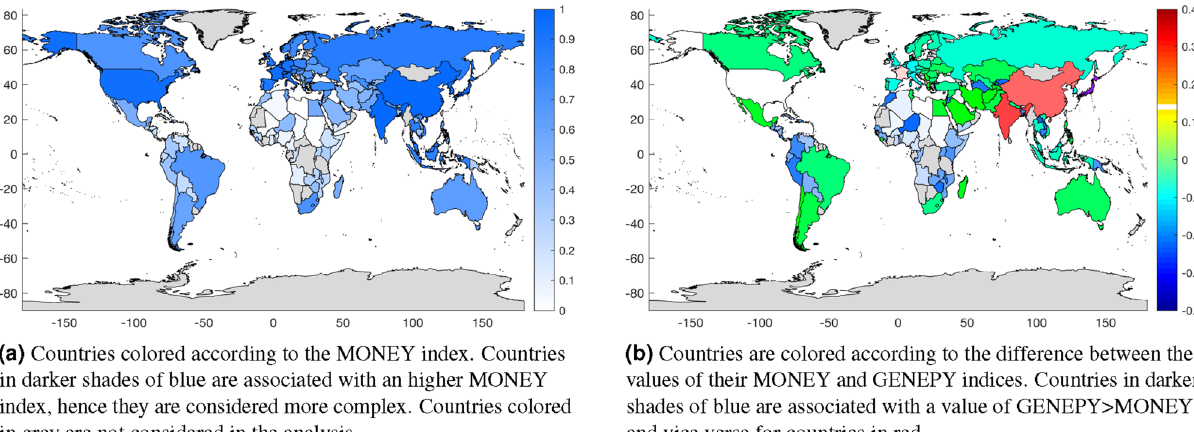
Figure 5. MONEY index for the year 2018 at the HS-4 level of aggregation and the difference with to the corresponding values of the GENEPY index for the same year and the same level of the product classification. The maps were generated using the MATLAB 2012b package borders , available for free (upon registration) at the following hyperlink: https:// it. mathw orks. com/ matla bcent ral/ filee xchan ge/ 50390- borde